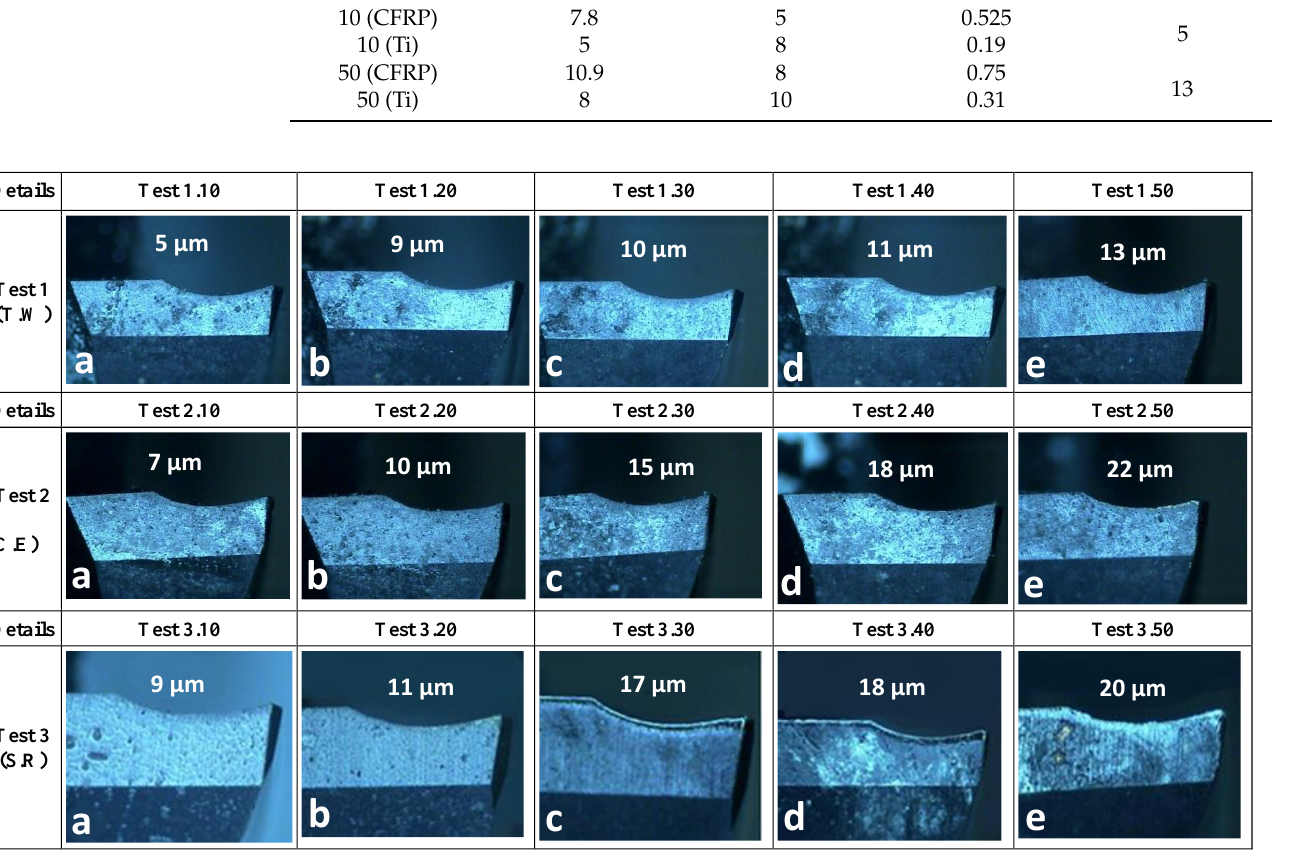
Table 13. Output Parameters at Optimal Flank Wear.